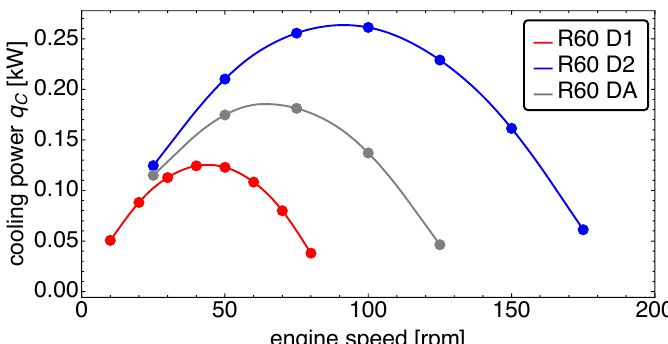
Figure 3. The cooling power for r = 0.6 regeneration extent is shown as a function of the engine speed for the three engine designs D1, D2, and DA. The cooling power for the D1 design is about half as large as that for the D2